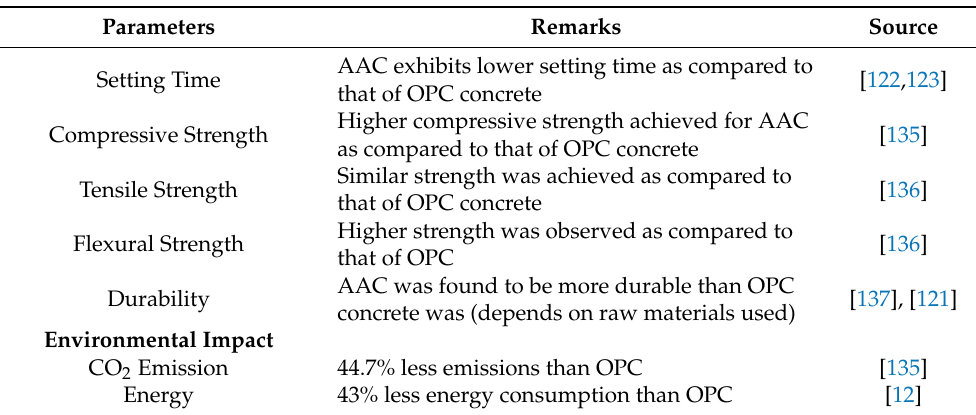
Table 6. Comparison of AAC and OPC